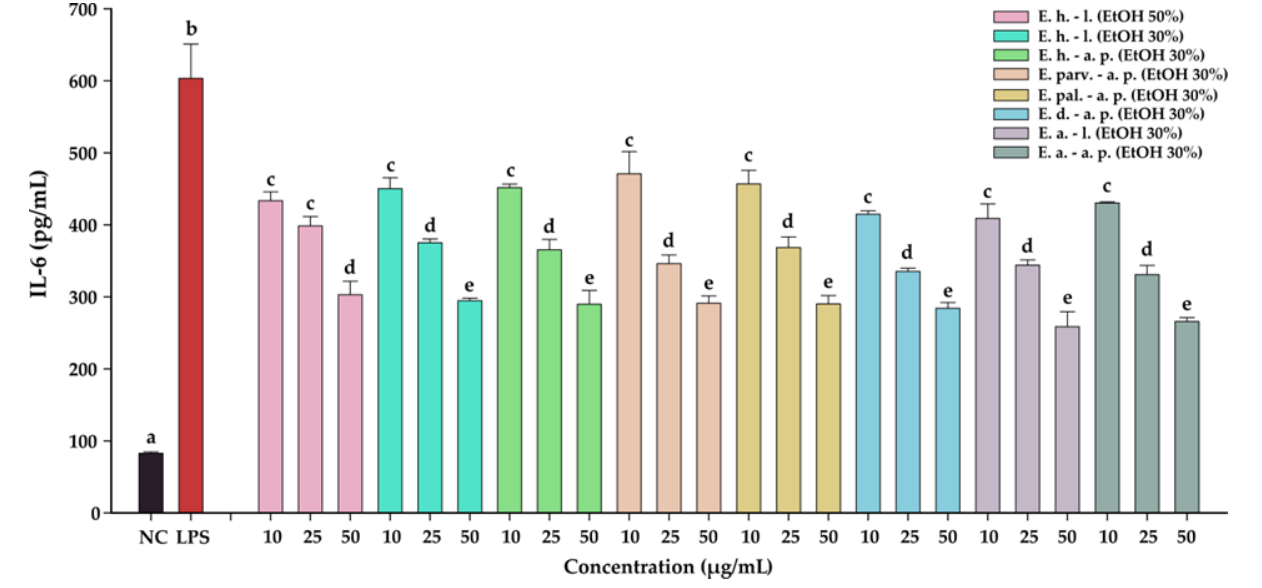
Figure 8. The anti-inflammatory potential of E. hirsutum leaves EtOH 50% (E. h. – l.), E. hirsutum leaves EtOH 30% (E. h. – l.), E. hirsutum aerial parts EtOH 30% (E. h. – a.p.), E. parviflorum aerial parts EtOH 30% ( E. parv. – a. p.), E. palustre aerial parts EtOH30% (E. pal. – a. p.), E. dodonaei aerial parts EtOH 30% (E. d. – a. p.), E. angustifolium leaves EtOH 30% (E. a. – l.), and E. angustifolium aerial parts EtOH 30% (E. a. – a. p.). The quantity of IL-8 was measured from cellular supernatants after a 24 h exposure to the extracts (10, 25, and 50 µg/mL) in combination with 100 ng/mL LPS. Different lowercase letters for bars representing the same extract and shown in identical colors indicate statistically significant differences in measured cytokine amounts (ANOVA + Holm- Sidak post hoc test at p<0.05 level of significance)